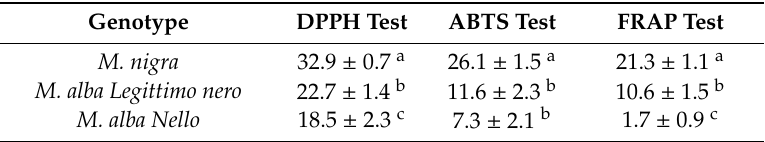
Table 3. Antioxidant activity of di ff erent mulberry genotypes evaluated by DPPH, ABTS and FRAP test. Results are expressed as µ mol Trolox Equivalents / g FW. Values represent the results of three determinations ± SD; means with di ff erent letters in the same column are significantly di ff erent from each other ( p < 0.05) according to the multicomponent Duncan’s